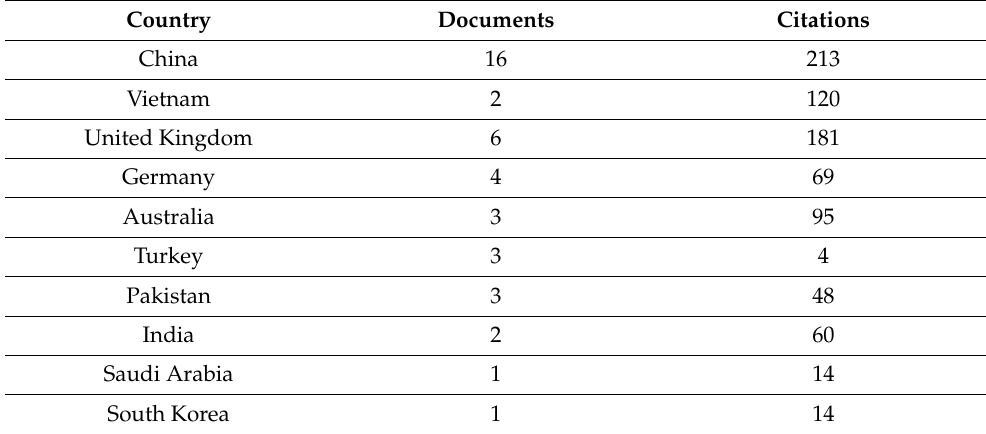
Table 3. Top 10 countries’ bibliometric coupling results based on total link strength.